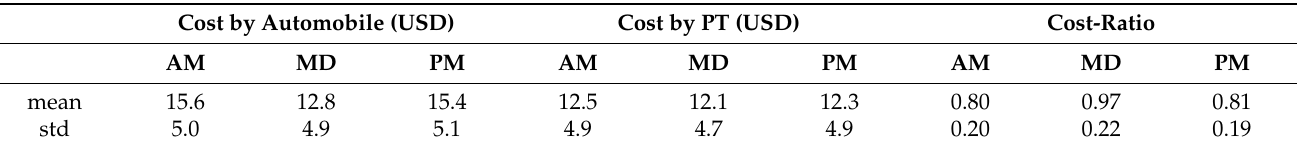
Table 2. Travel cost by two modes and cost-ratio for the three time periods. Cost by Automobile (USD)